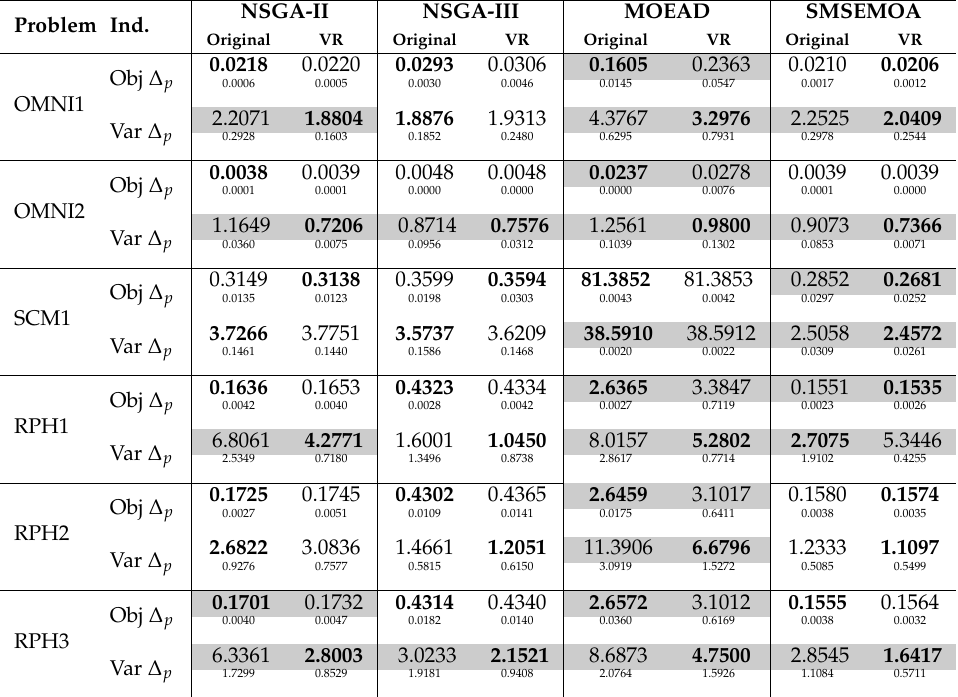
Table 3. Numerical results for the original and variation rate version of some MOEAs in Type III test problems. We show the mean and standard deviation (up and down in the cell, respectively). We put in bold the best value and in gar the cells with statistical significance according to the Wilcoxon test. Problem Ind.